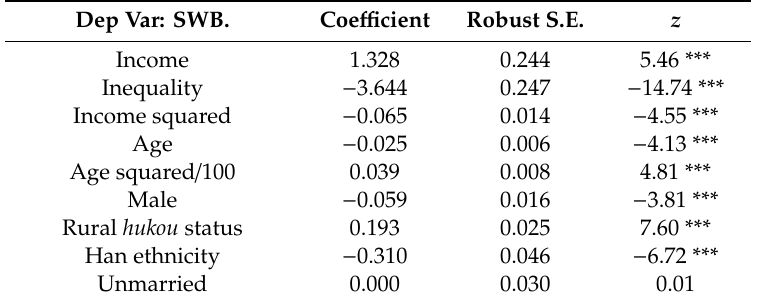
Table A1. Additional robust test results: putting “It is hard to say” answers together with “Unhappy”. Dep Var: